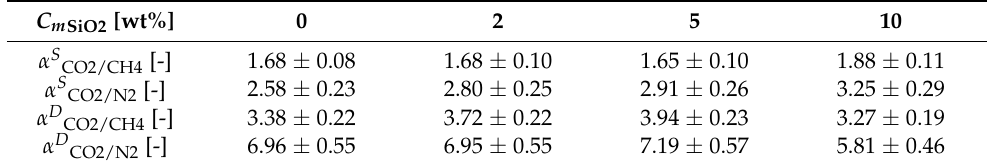
Table A9. Coefficients α S i/j and α D i/j for membranes of different SiO 2 concentrations.